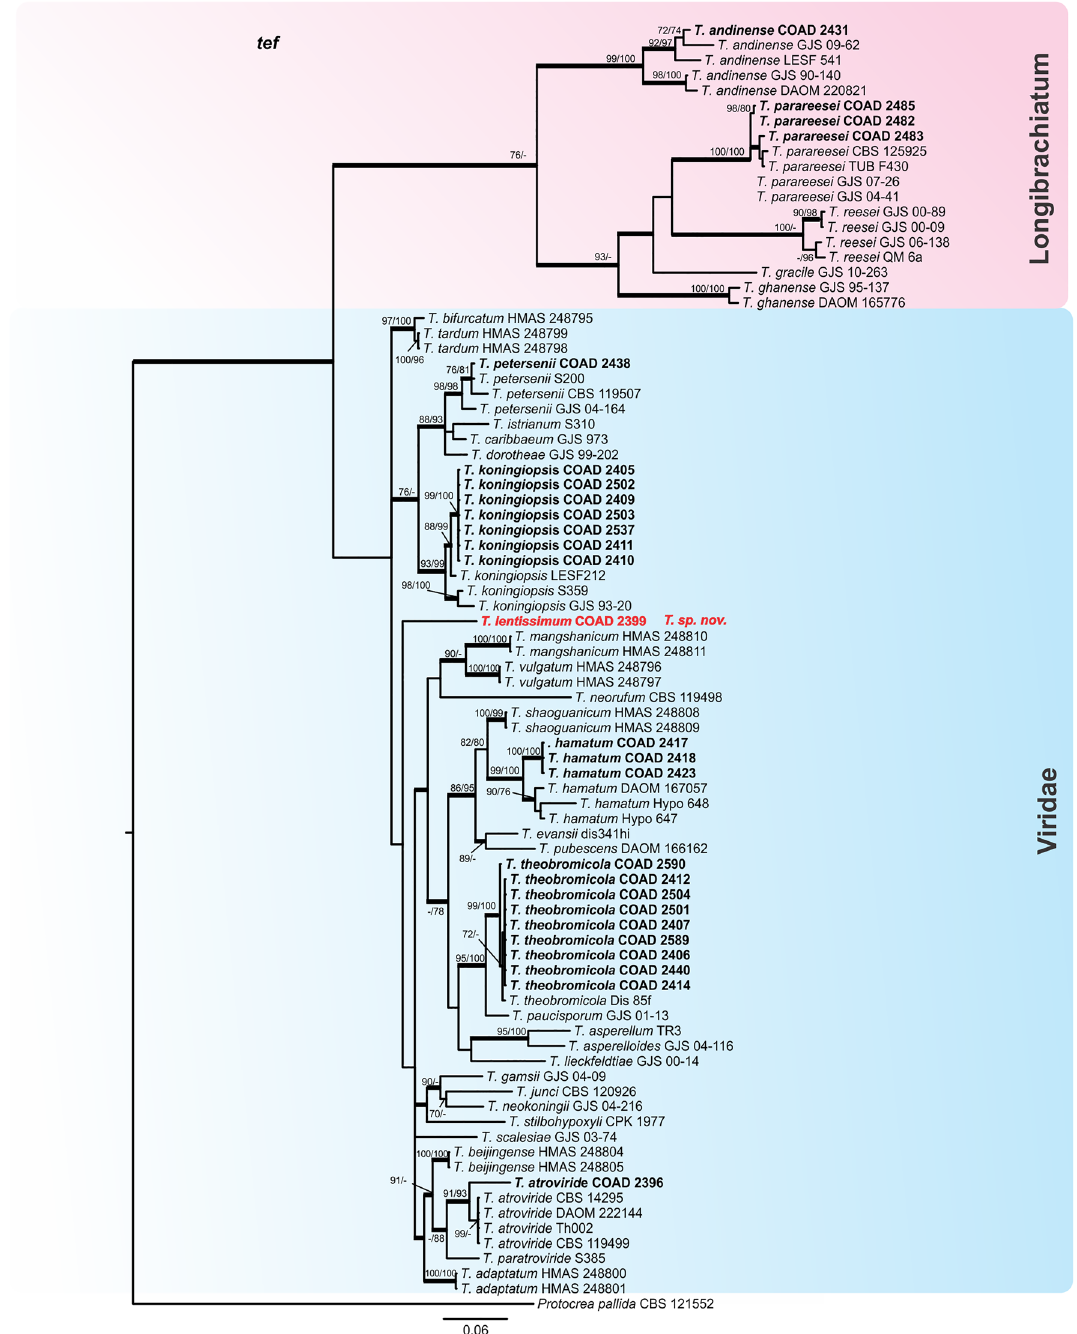
Figure 6. Bayesian phylogenetic tree of clades Longibrachiatum and Viride . The tree was based on tef1 sequence dataset. Bootstrap values (≥ 70%) of the ML analyses, as well as posterior probability scores (≥ 0.9) from a Bayesian analysis of the same dataset, are indicated at well supported nodes together with thickened branches. The isolates from known species obtained in this study are in bold. Isolates belonging to new species, described in this study, are in bold red. The tree was rooted with Protocrea pallida (CBS 121552). The phylogenetic tree was edited using Inkscape 1.0 (https ://inksc